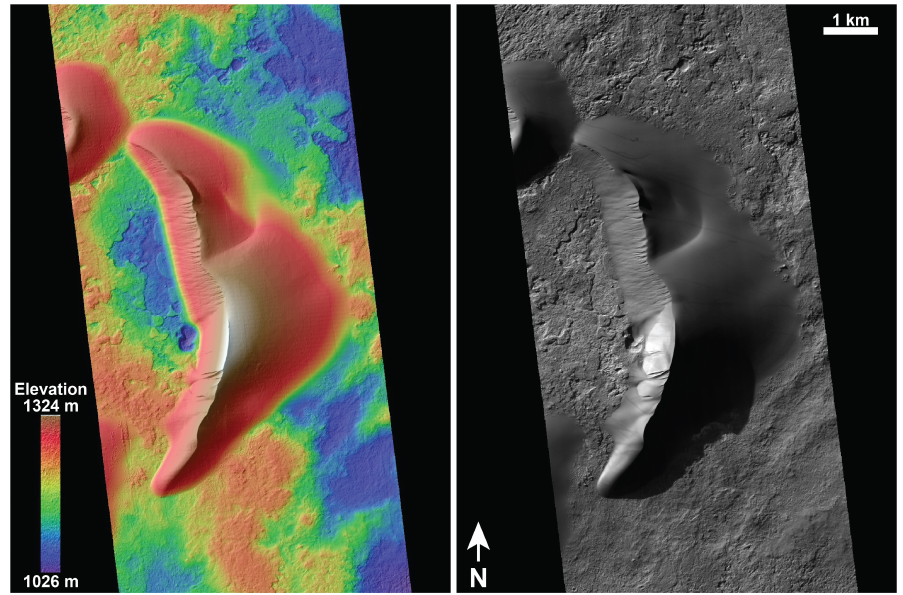
Figure 17. DTM (DTEED_016907_1330_016973_1330_U01) and orthoimage (ESP_016907_1330_ RED_D_01_ORTHO, illumination from upper left) featuring a megabarchan dune in Kaiser crater (46.74 ◦ S, 20.15 ◦ E). The west-facing slipface of the dune has many annually active